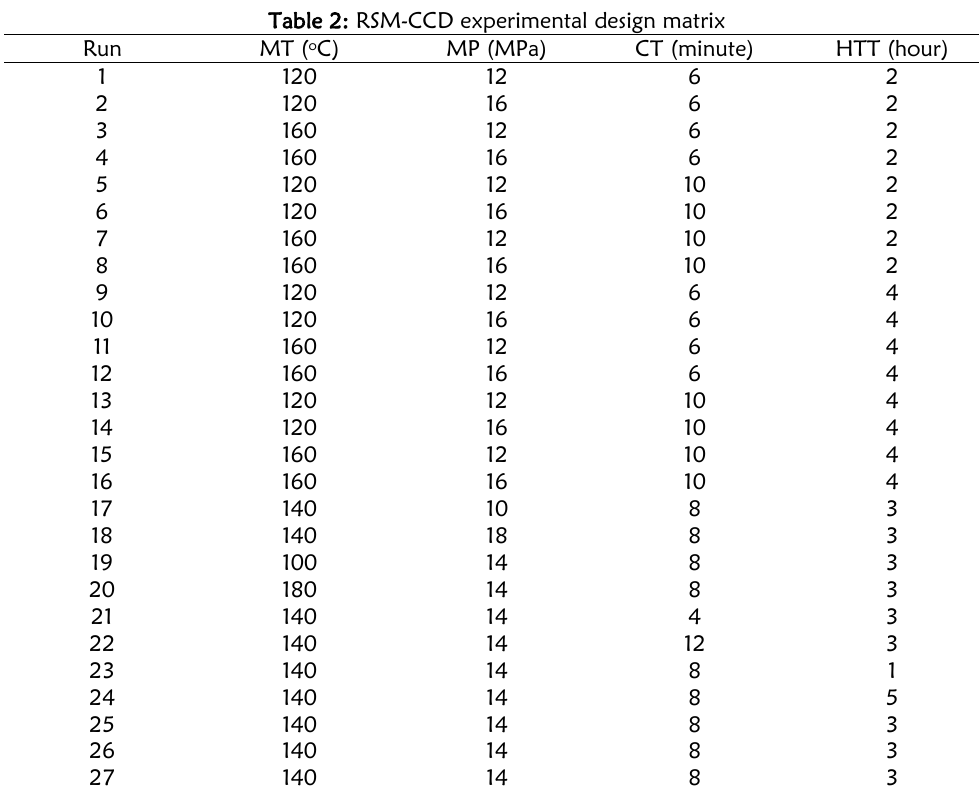
Table 2: RSM-CCD experimental design